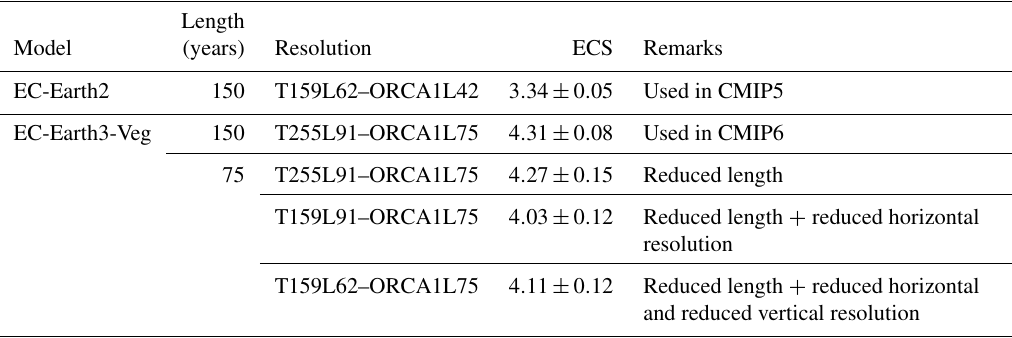
Table 3. Impact of a reduced simulation length and reduced model resolution on the ECS. The ECS value for EC-Earth2 is shown for comparison.